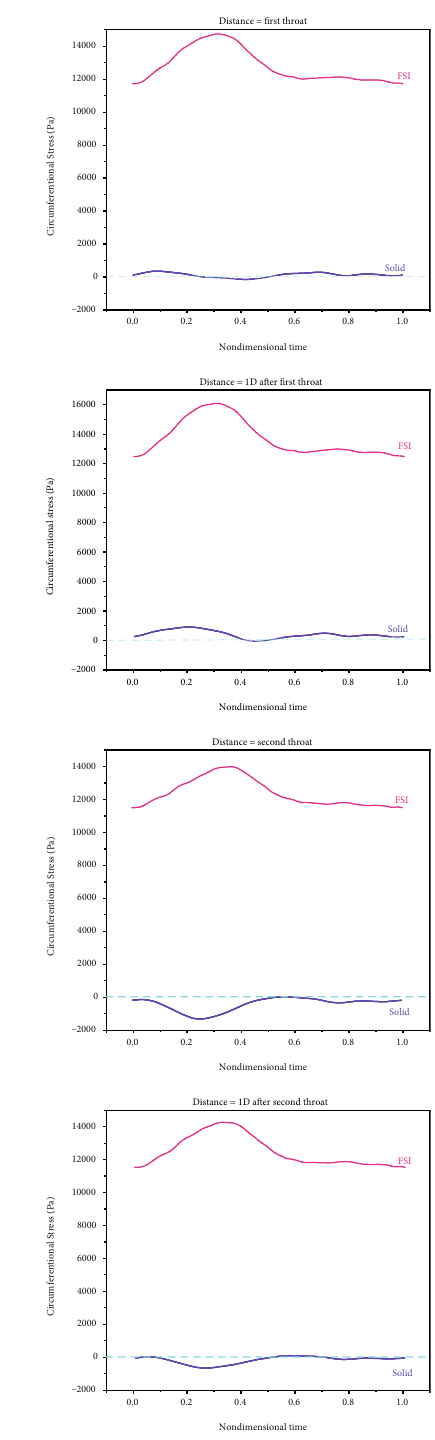
Figure 11: Comparing the circumferential stresses of the rigid and elastic walls in double stenosis.